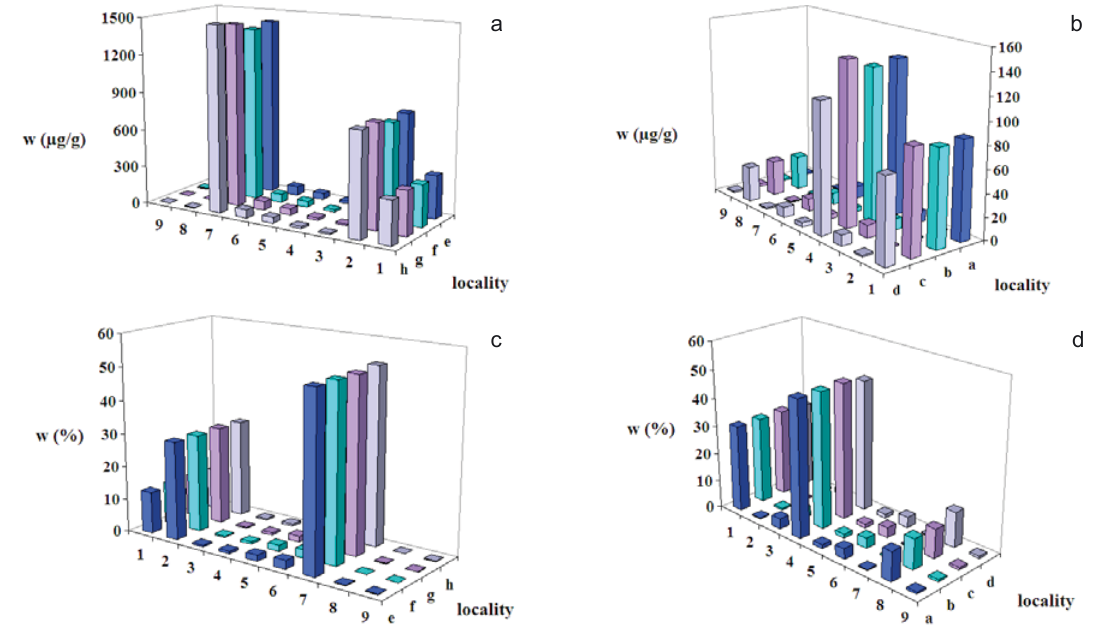
Figure 7. The effect of locality on the amount (a,b) an representation (c,d) of terpenes in P. abies L. Karst . and J. regia L . Individual terpenes: 1 - (+)- a -pinene, 2 - (-)-camphene, 3 – sabinene, 4 - (-)- b -pinene, 5 – myrcene, 6 - R-(+)-limonene, 7 - (-)-bornylacetate, 8 - (-)- trans -caryophyllene, 9 - a -humulene, locality: a, e – Brno, b, f – Jevíčko, c, g – V. Meziříčí, d, h – Bílá